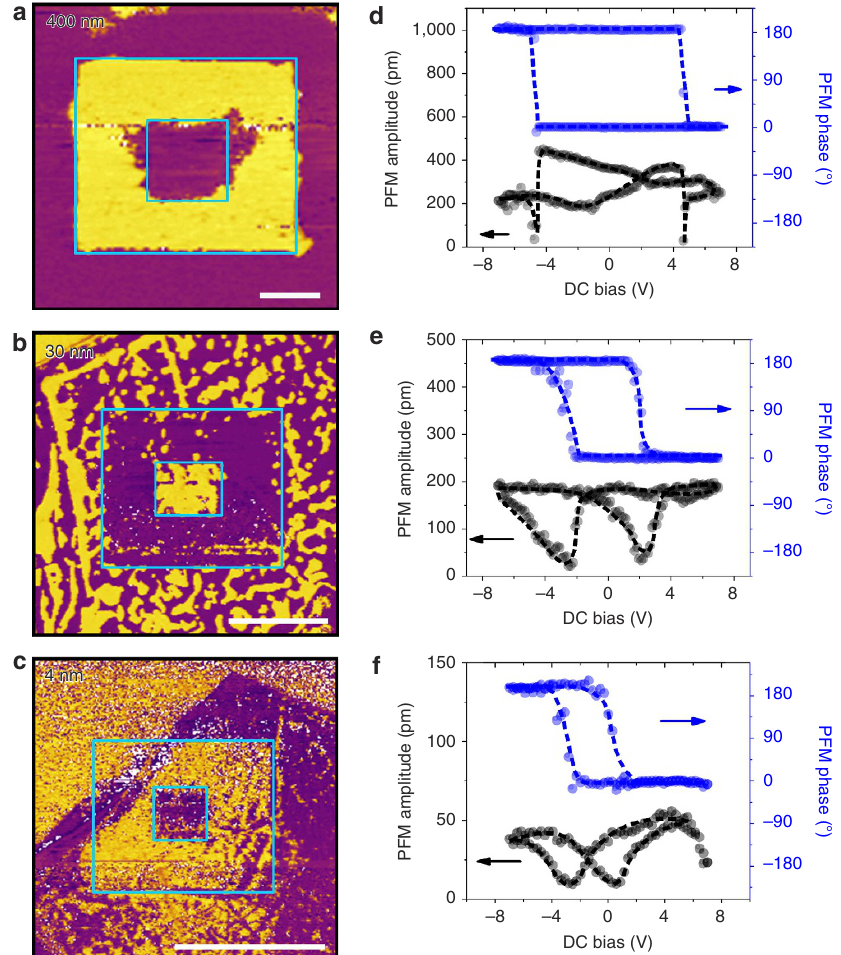
Figure 3 | Ferroelectric polarization switching by PFM for CIPS flakes with different thicknesses. ( a – c ) The PFM phase images for 400nm ( a ) 30nm ( b ) and 4nm ( c ) thick CIPS flakes with written box-in-box patterns with reverse DC bias. Scale bar, 1 m m. ( d – f ) The corresponding PFM amplitude (black) and phase (blue) hysteresis loops during the switching process for 400nm ( d ) 30nm ( e ) and 4nm ( f ) thick CIPS flakes.